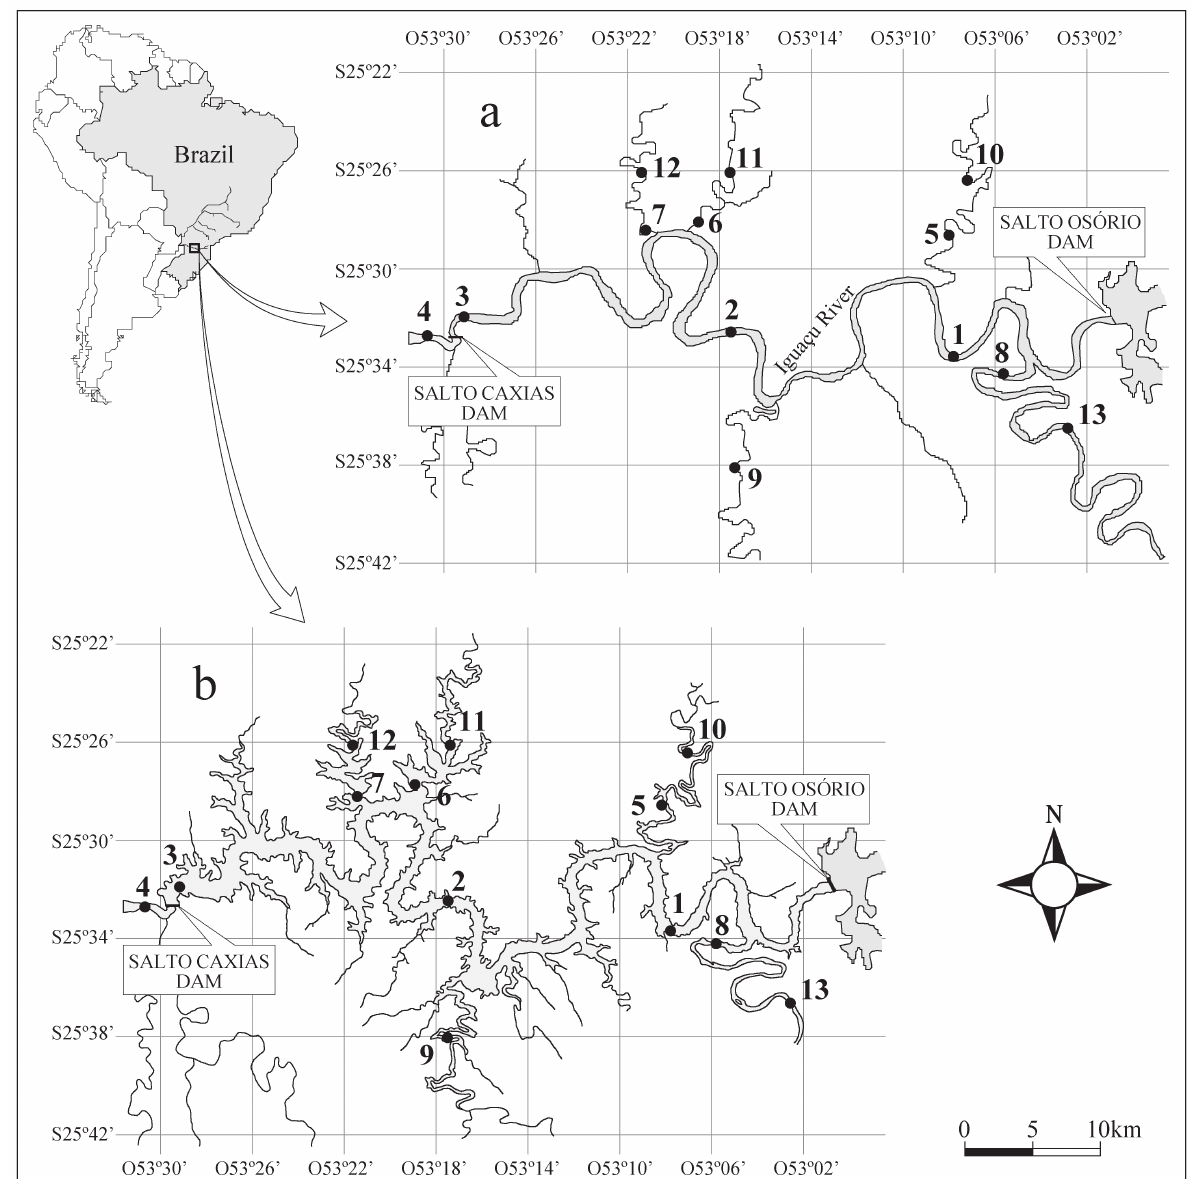
Fig. 1. Location of the sample stations in the Iguaçu River and the dam influence area. a) Before damming. b) After damming. [Point 1-2 = upstream from the Iguaçu river (UP); point 3 = reservoir region (RE); point 4 = downstream (DO); 5-9 = tributaries low section (TL); 10-14= tributaries upper section